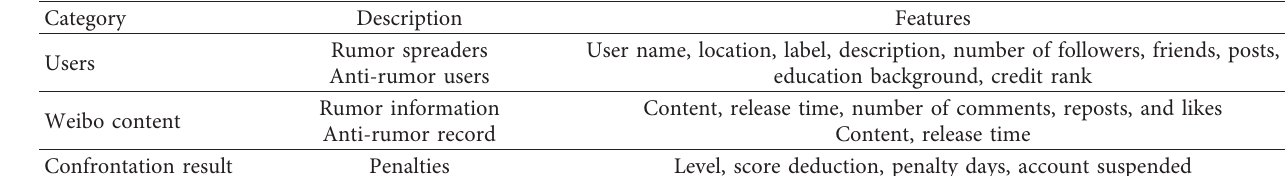
Figure 1: Number of anti-rumors over time. Black line represents the monthly data, and the blue line is the average data of each year. Table 1: Instructions of features in the false information publicity